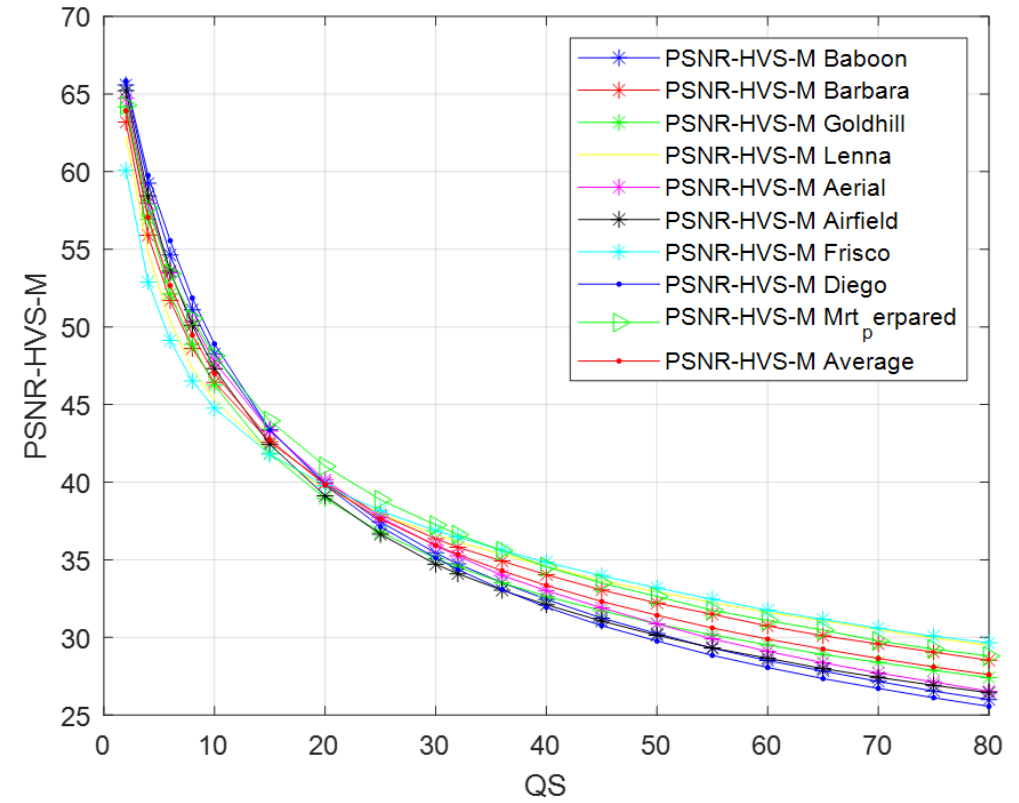
Figure 12. Dependences PSNR-HVS-M on QS for nine test images (see the list in the upper part of the plot) and the average curve for AGU.